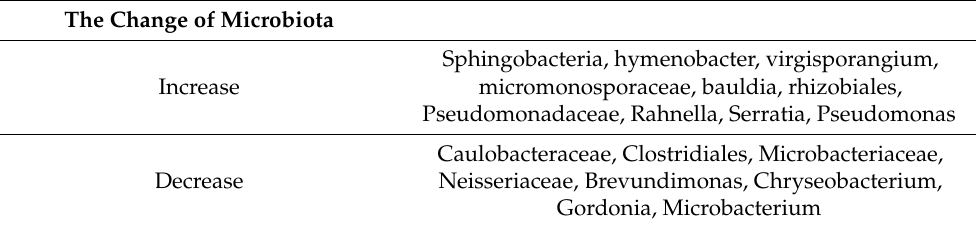
Table 5. Microbiota commonly identified in blood